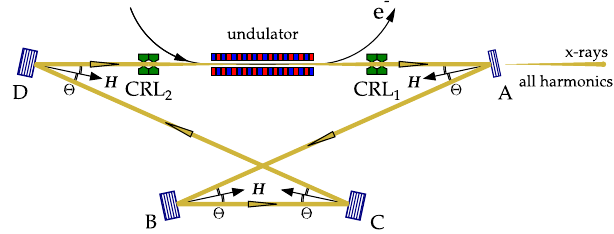
FIG. 1. Schematic of a cavity-based XFEL with a tunable optical cavity composed of four Bragg-reflecting flat-crystal mirrors (A,B,C, and D) and compound refractive lenses (CRLs) as focusing elements [6]. X-ray power is coupled out of the cavity though permeable thin crystal A with reduced reflectivity. The incidence and reflection angles Θ ¼ π = 2 − θ are the same for all crystals, where θ is Bragg ’ s